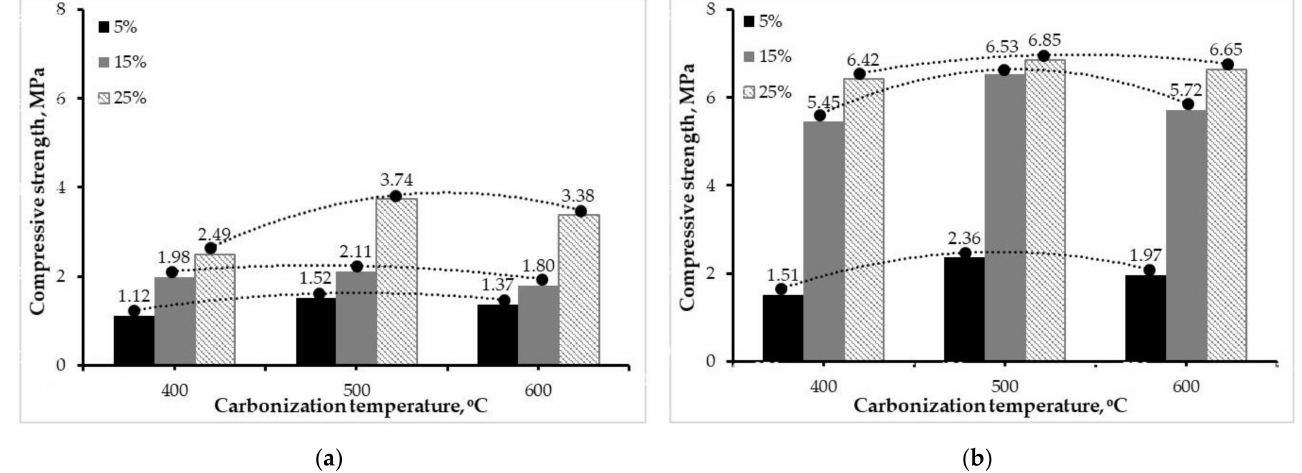
Figure 6. Compressive strength of biocoke from briquettes of ( a ) rice husks and ( b ) coconut